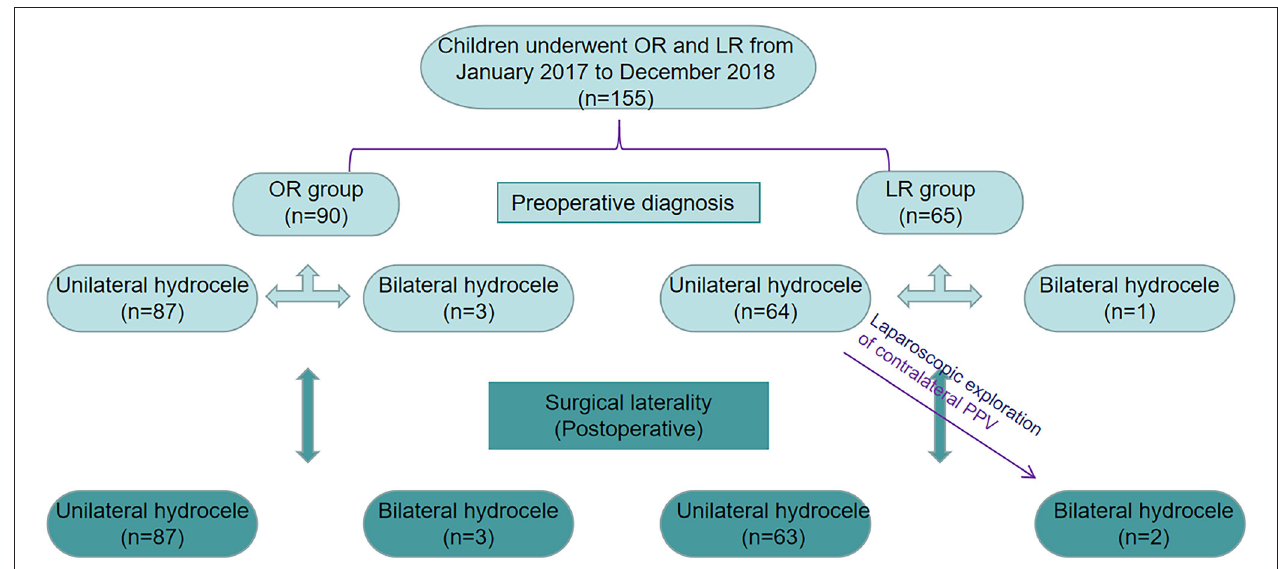
FIGURE 3 | Identification of patients underwent open surgery communicating hydrocele repair and laparoscopic hydrocele repair.